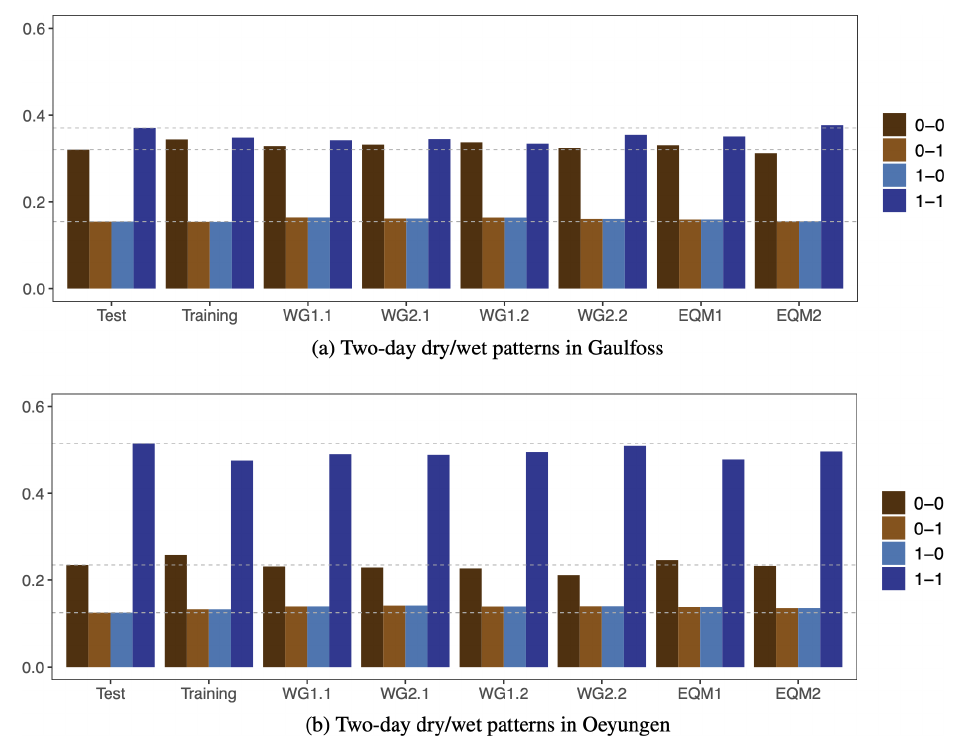
Figure 8. Proportion of different 2d dry–wet patterns for the seNorge data in the training period 1957–1986 and the test period 1987–2005 as well as for six different simulations of the test period. The results are aggregated over all grid cells in the catchments Gaulfoss (a) and Oeyungen (b) . Dry days are indicated with 0 and wet days with 1. For ease of interpretation, horizontal dashed lines are drawn at the levels of the test